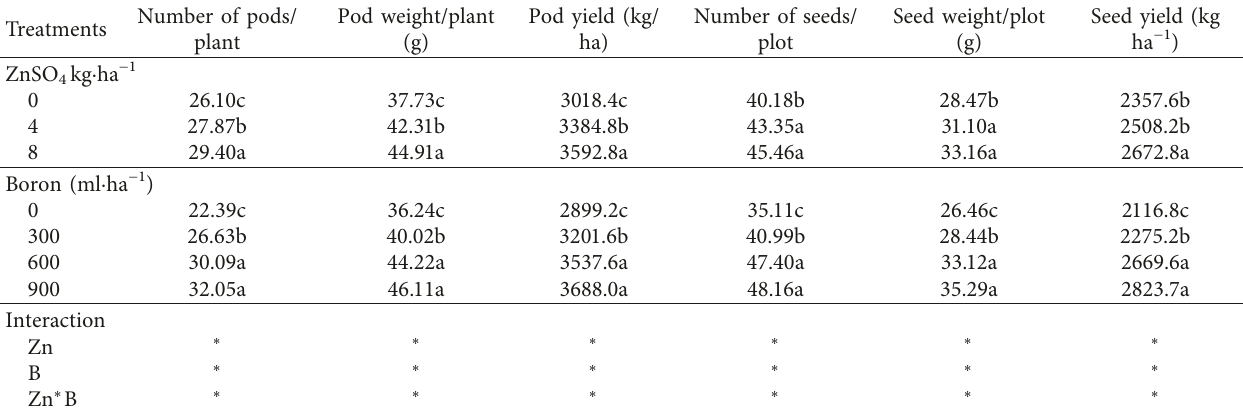
Table 4: Effects of zinc and boron fertilizers on pod and seed yield of groundnut (pooled data of 2016 and 2017 cropping seasons).